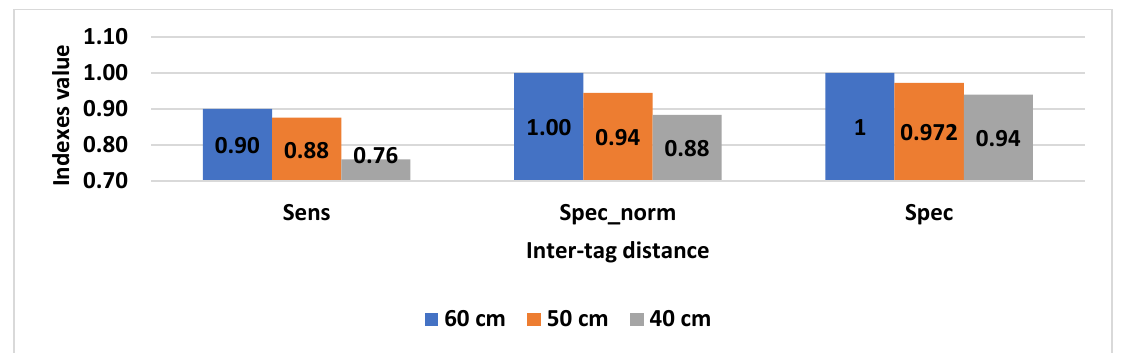
Figure 12. Sensitivity, specificity, and normalized specificity for each considered ∆T.